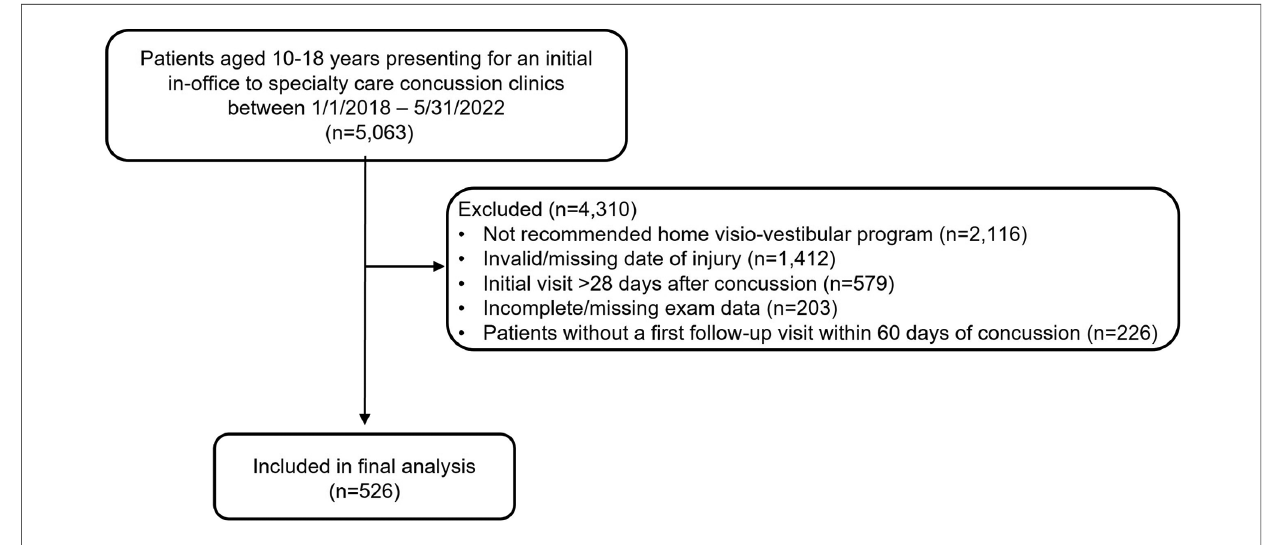
FIGURE 1 Consort diagram for patients included in fi nal